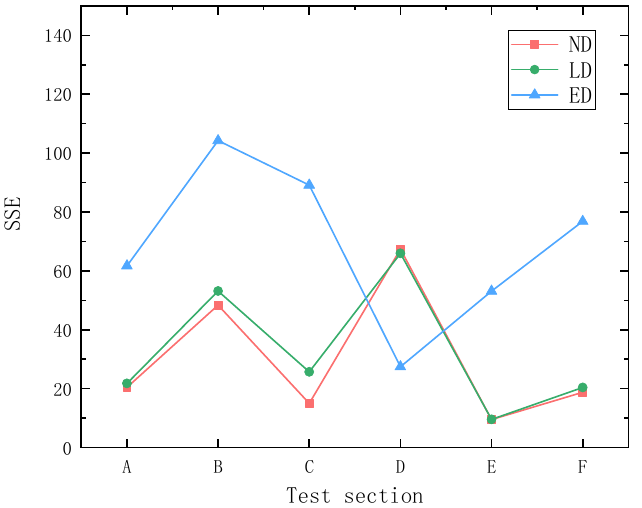
Figure 10. Sum of squares of errors for different probability distribution models.